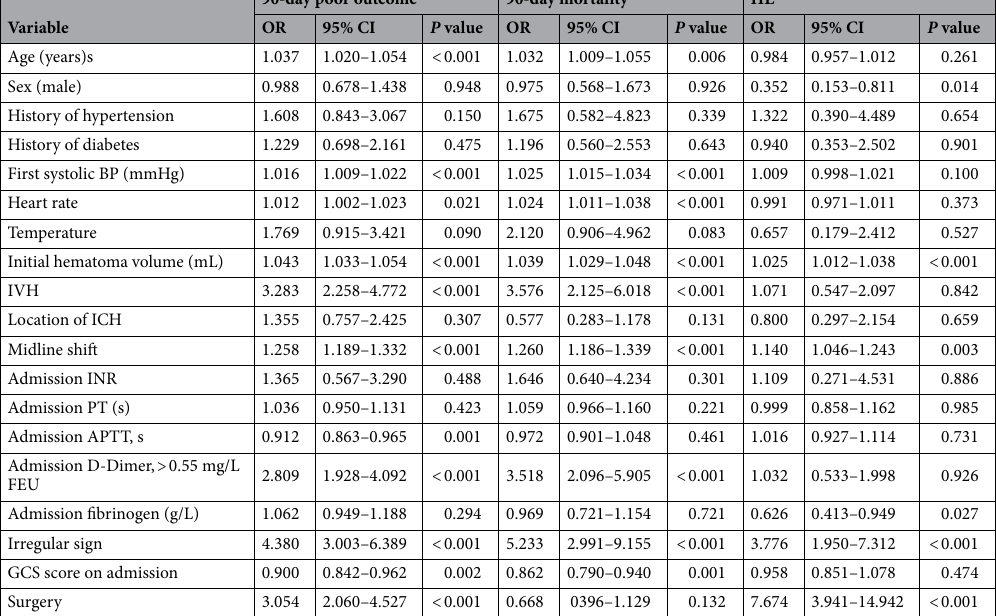
Table 2. Univariate associations with poor functional outcomes (mRS 3–6) and mortality and hematoma expansion. APTT = activated partial thromboplastin time, BP = blood pressure; CI = confidence interval; GCS = Glasgow Coma Scale; ICH = intracerebral hemorrhage; INR = international normalized ratio; IVH = intraventricular hemorrhage on presentation; mRS = modified Rankin Scale; NIHSS = NIH Stroke Scale; PT = prothrombin time. Values are n (%), mean ± SD, or median (interquartile